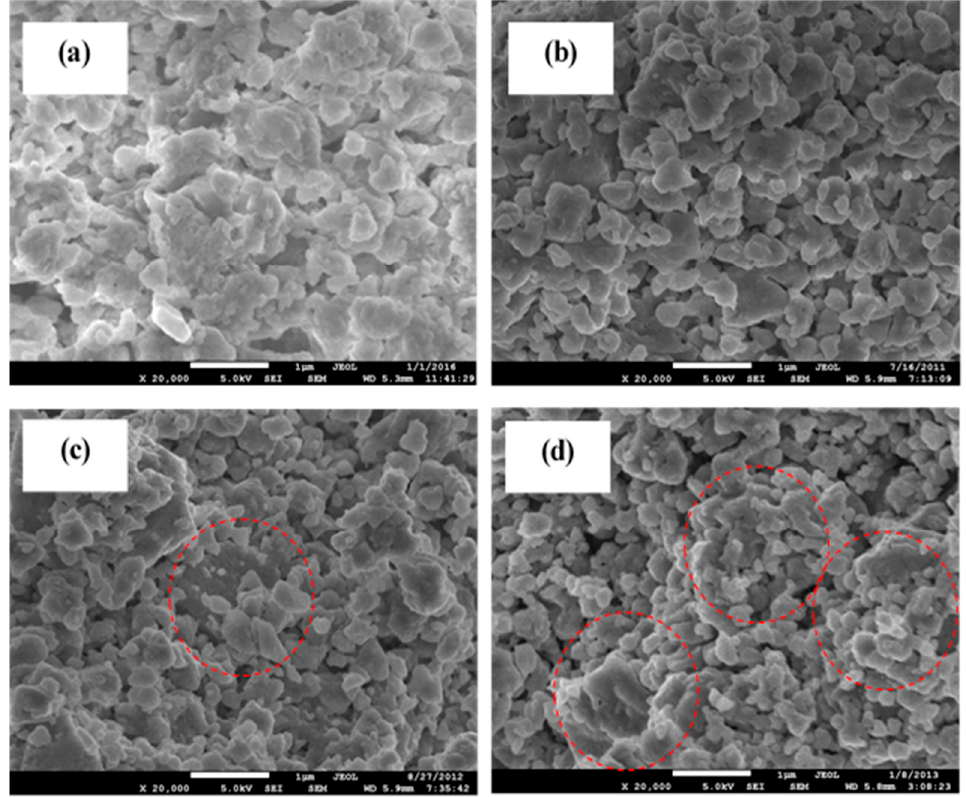
Figure 5. FESEM micrograph of the Li 1+x Al x Ti x Sn 2-2x P 3 O 12 with x equal to ( a ) 0.2, ( b ) 0.4, ( c ) 0.6 and ( d ) 0.8 sintered at 650 °C. Dotted red circle represents the bimodal grain size distribution.